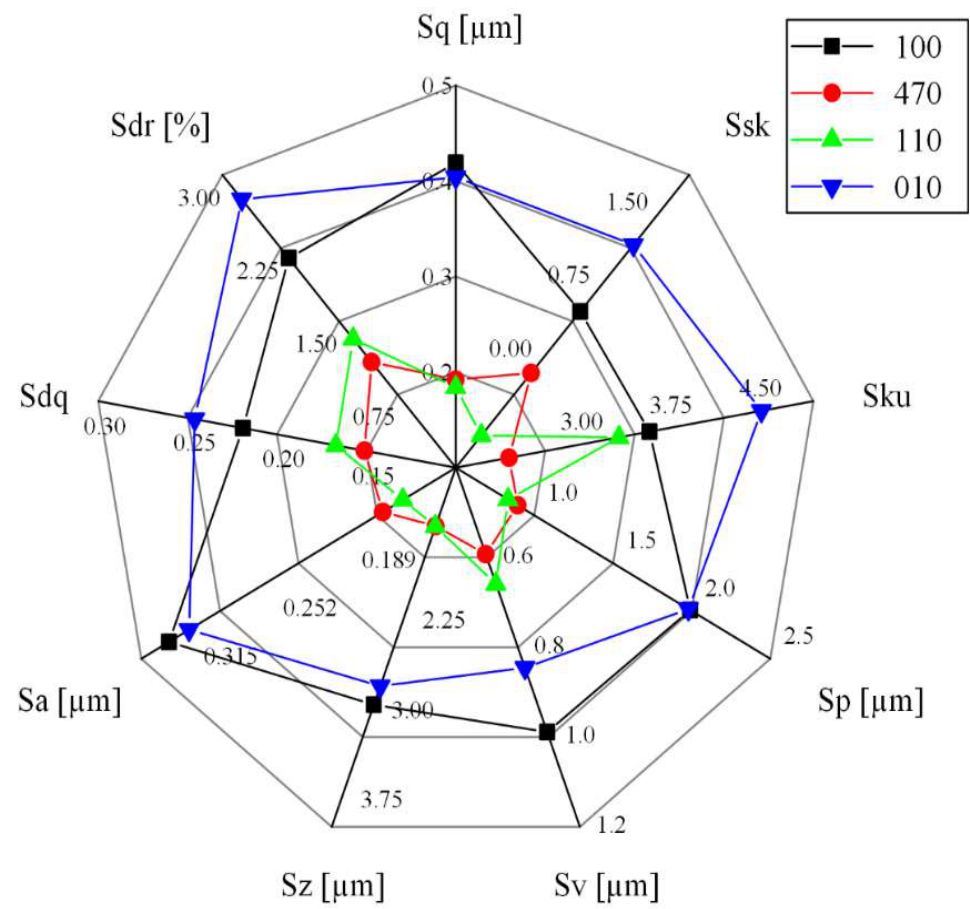
Figure 6. Surface Roughness of slot bottoms milled along different crystal directions. Where Sq (root mean square height), Ssk (skewness), Sku (kurtosis), Sp (maximum peak height), Sv (maximum pit height), Sz (maximum height), Sa (Arithmetical mean height), Sdq (root mean square slope), and Sdr (developed area ratio) can be described by Equations (7)–(13), respectively, and which Ref. to ISO-25178. The A is the length of meas- urement.